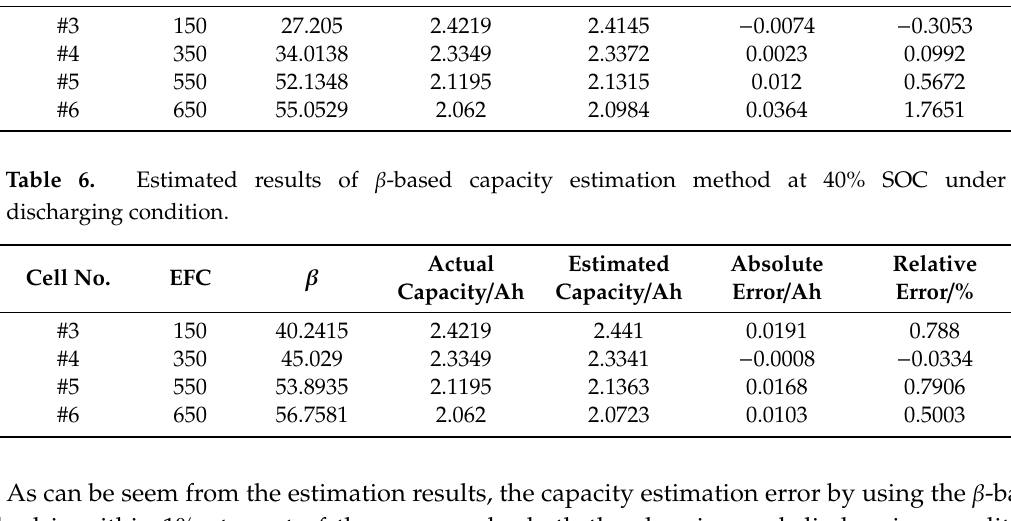
Table 5. Estimated results of β -based capacity estimation method at 70% SOC under charging condition. Cell No.